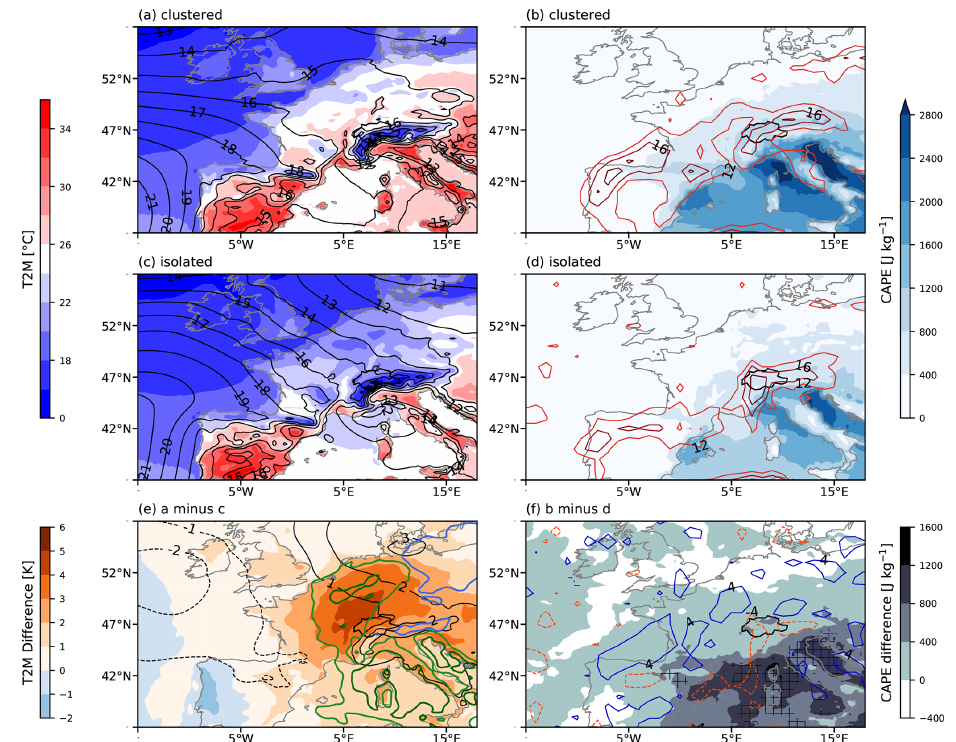
Figure 10. Weather patterns during clustered and isolated hail days south of the Alps. (a) T2M and MSLP during clustered hail days; (b) front frequency and MUCAPE during clustered hail days. (c, d) Same as panels (a) and (b) but during isolated hail days. (e, f) Differences of clustered minus isolated patterns. In panel (e) the significances of differences for MSLP (T2M) are shown in blue (green), and in panel (f) the significances of differences for MUCAPE are shown in blue hashes. See Fig. 6 for more details.